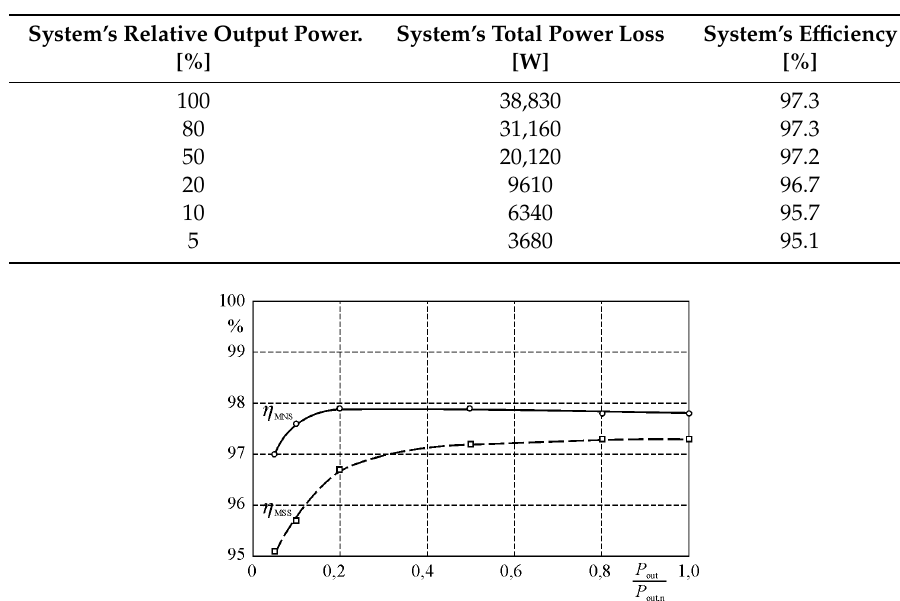
Table 4. Power loss and system’s e ffi ciency in the MSS.